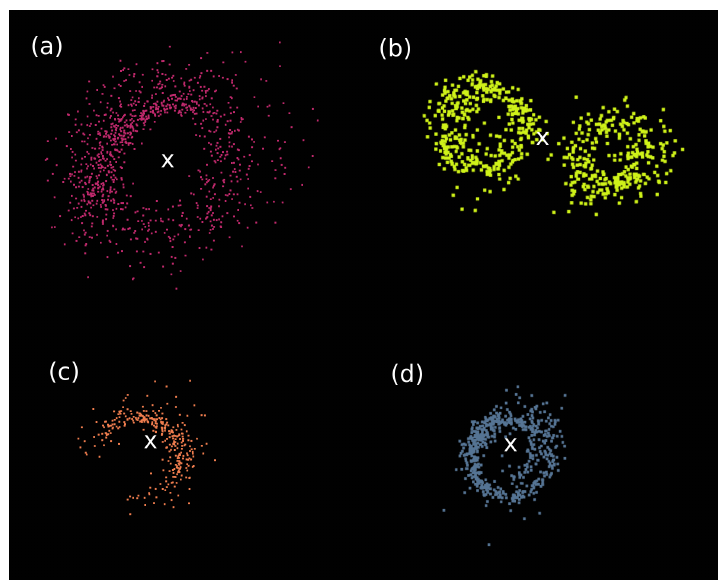
Figure 8. ( a – d ) Cross sections of some trunk clusters with its gravity centers marked as white